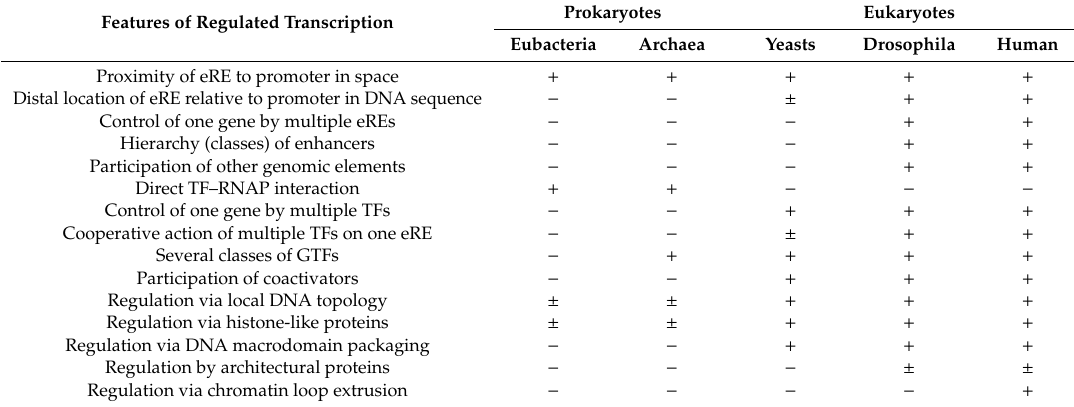
Table 1. Features of transcription driven by enhancers and enhancer-like regulatory elements (eREs) in di ff erent